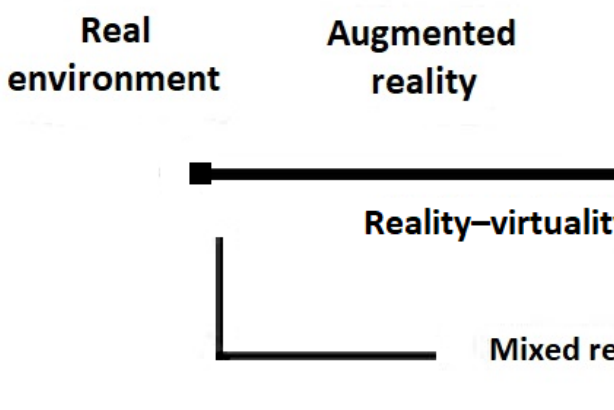
Figure 1. Reality–virtuality continuum framework